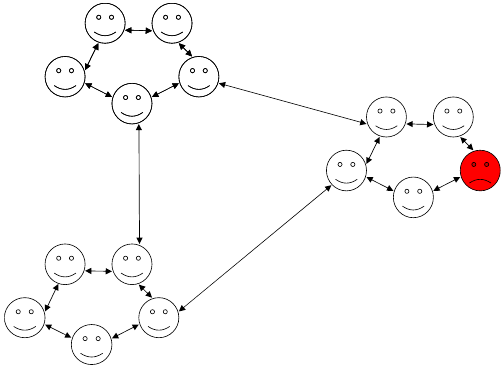
Figure 1. Topology of Darknet. A participant with malicious intent (e.g., a red one) cannot easily understand the entire